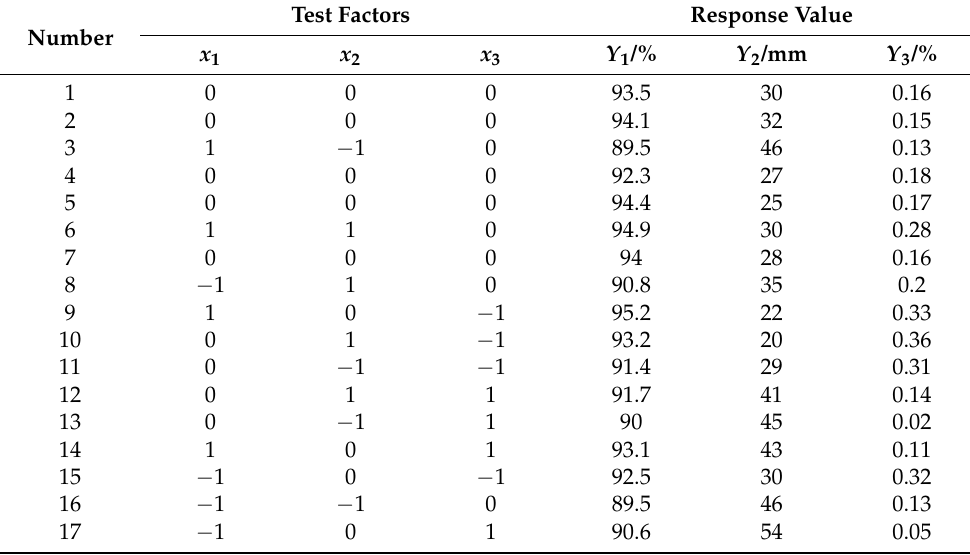
Table 4. Test scheme and